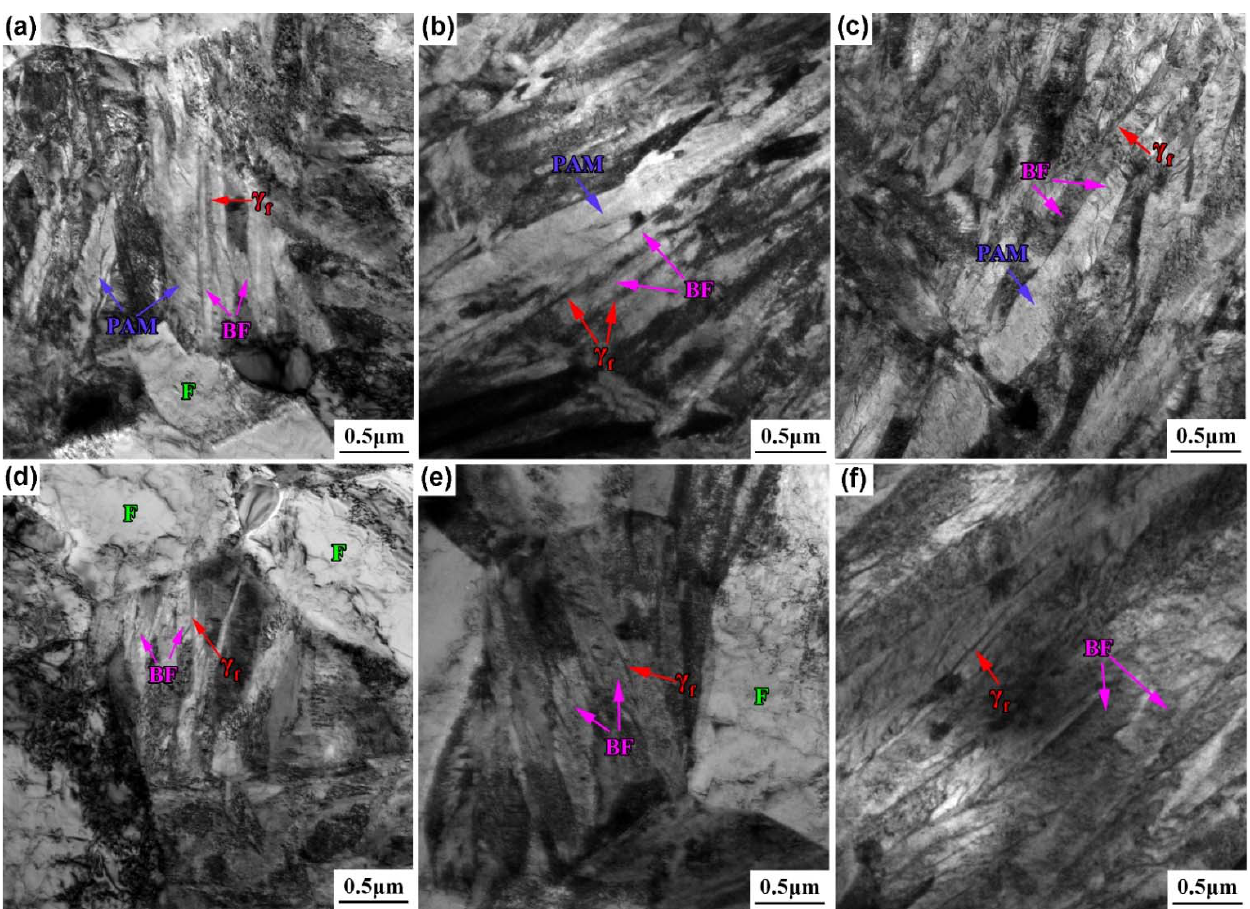
Figure 4. TEM microstructures of the test steel at different heat treatment processes. ( a ): 750–190 ◦ C, ( b ): 760–230 ◦ C, ( c ): 770–270 ◦ C, ( d ): 750–230 ◦ C, ( e ): 760–270, ( f ): 770–290 ◦ C.